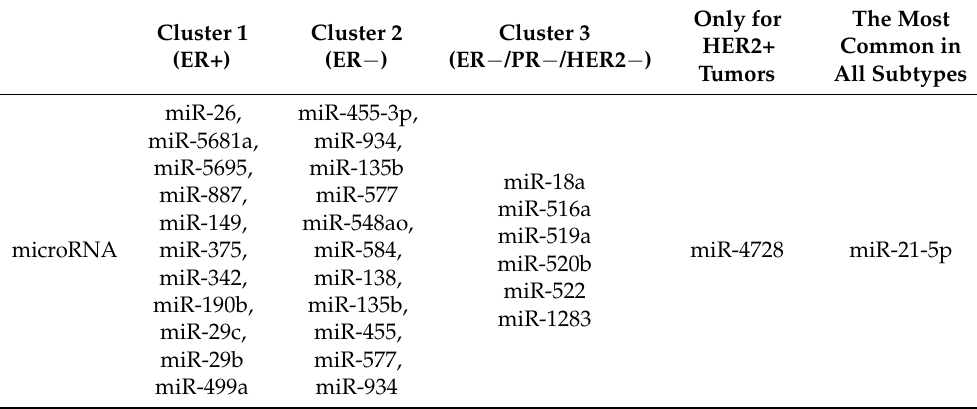
Table 2. The variety of microRNAs in different subtypes of breast cancer. Cluster 1 contains luminal A samples and some luminal B; Cluster 2 mostly contains luminal B; Cluster 3 includes only basal- like subtype. HER2+ tumors were identified as a sub-cluster as they had features of Cluster 1 and Cluster 2. The Most Only for Cluster 1 Cluster 2 Cluster 3 Common in HER2+ (ER+) (ER − ) (ER − /PR − /HER2 − ) All Subtypes Tumors miR-26, miR-5681a, miR-5695, microRNA